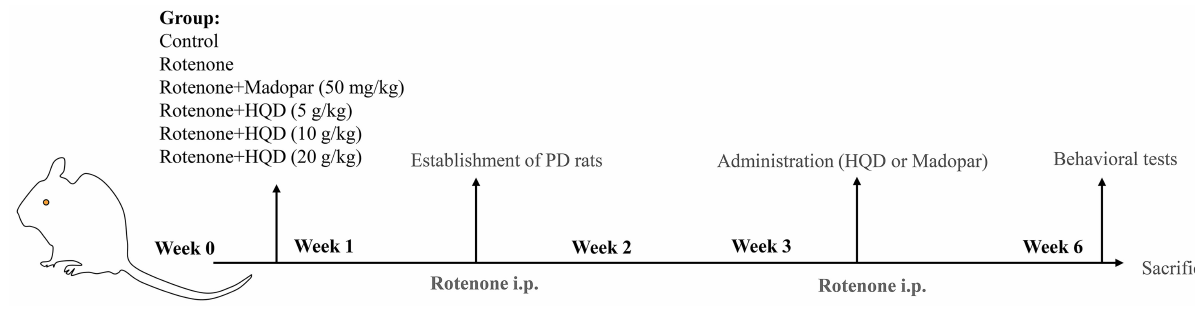
FIGURE 1 | The design of animal